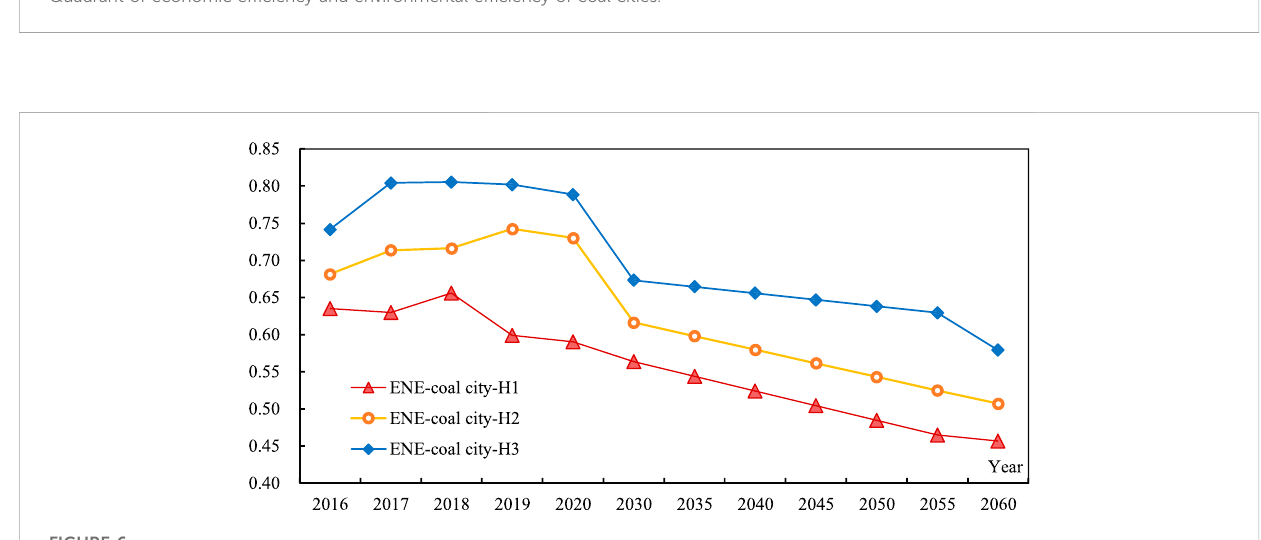
The ENE of coal city in the carbon reduction